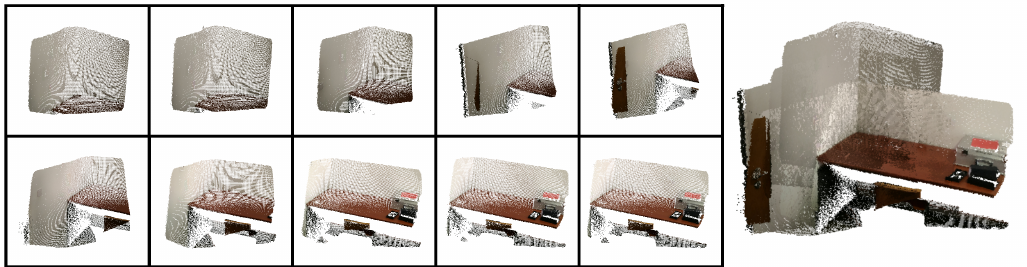
Figure 1. Example of registration of several point 3D point clouds to create a complete 3D